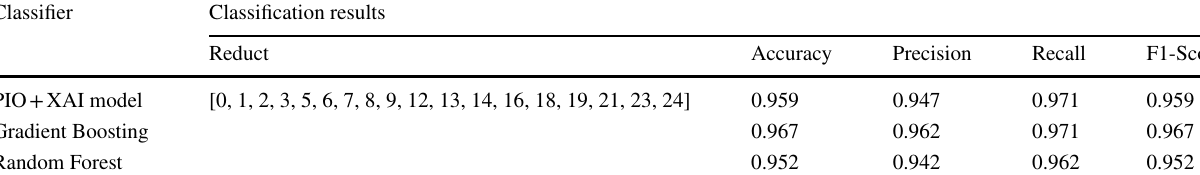
Table 7 Comparative performance results of Gradient Boosting and Random Forest classifiers